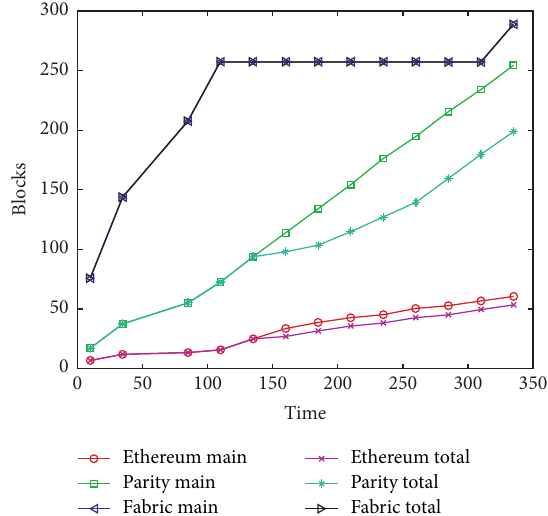
Figure 9: Blockchain forks caused by attacks.